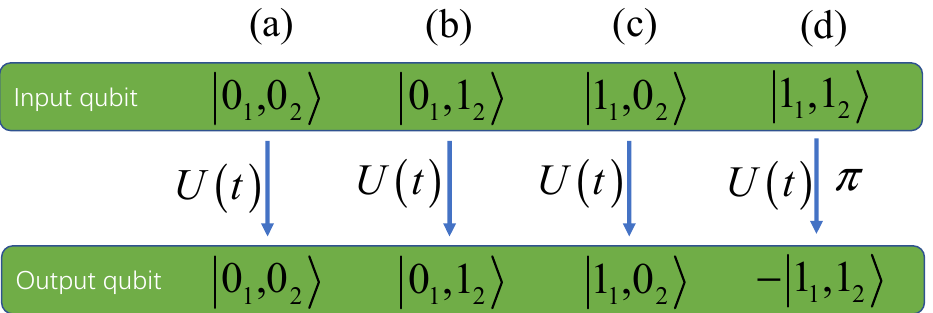
Figure 2. The procedure diagram for a two-qubit quantum logic gate protocol using effective Hamiltonian (8).